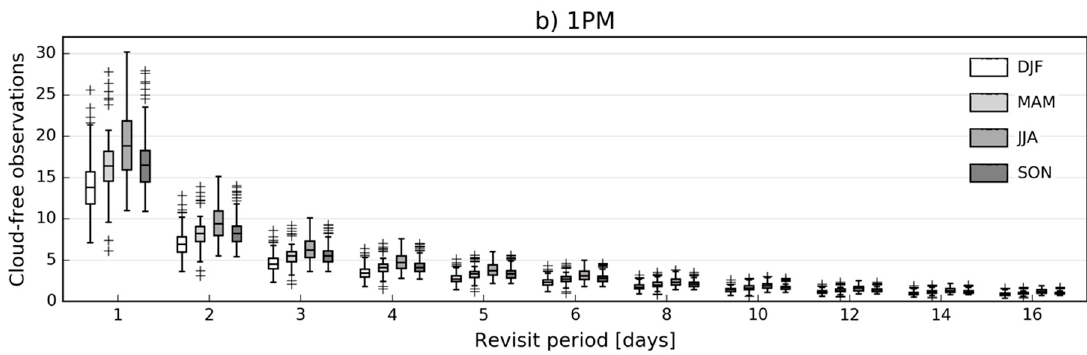
Figure 2. Number of cloud-free observations per month derived from ground-based incoming shortwave radiation at 10:00 ( a ) and 13:00 ( b ) at the 21 flux towers. Average results over all the sites depending on season periods: December, January and February (DJF); March, April and May (MAM); June, July and August (JJA); and September, October and November (SON). The boxes extend from the lower to upper quartile values of the data, with a line at the median. The whiskers represent 1.5 interquartile range below and above the boxes.